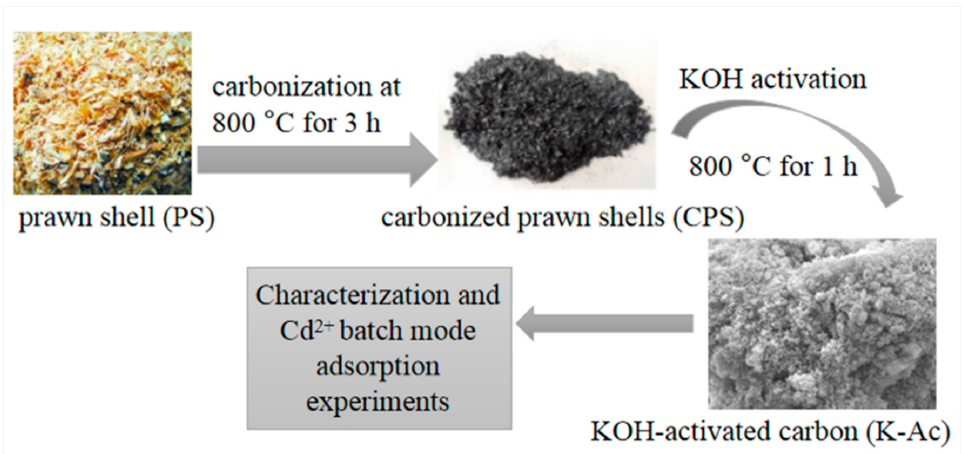
Figure 1. Diagram of the K-Ac preparation process .